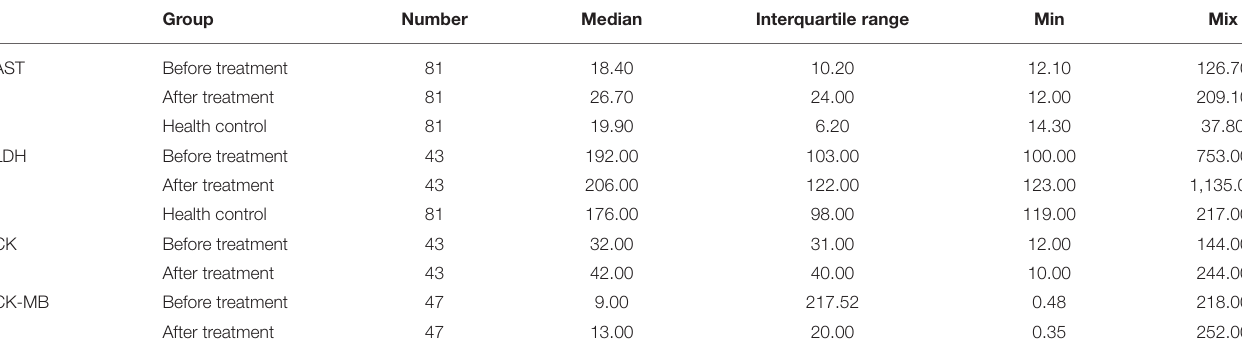
TABLE 2 | The detailed characteristics of serum AST, LDH, CK and CK-MB activities in patients and health control. Group Number Median